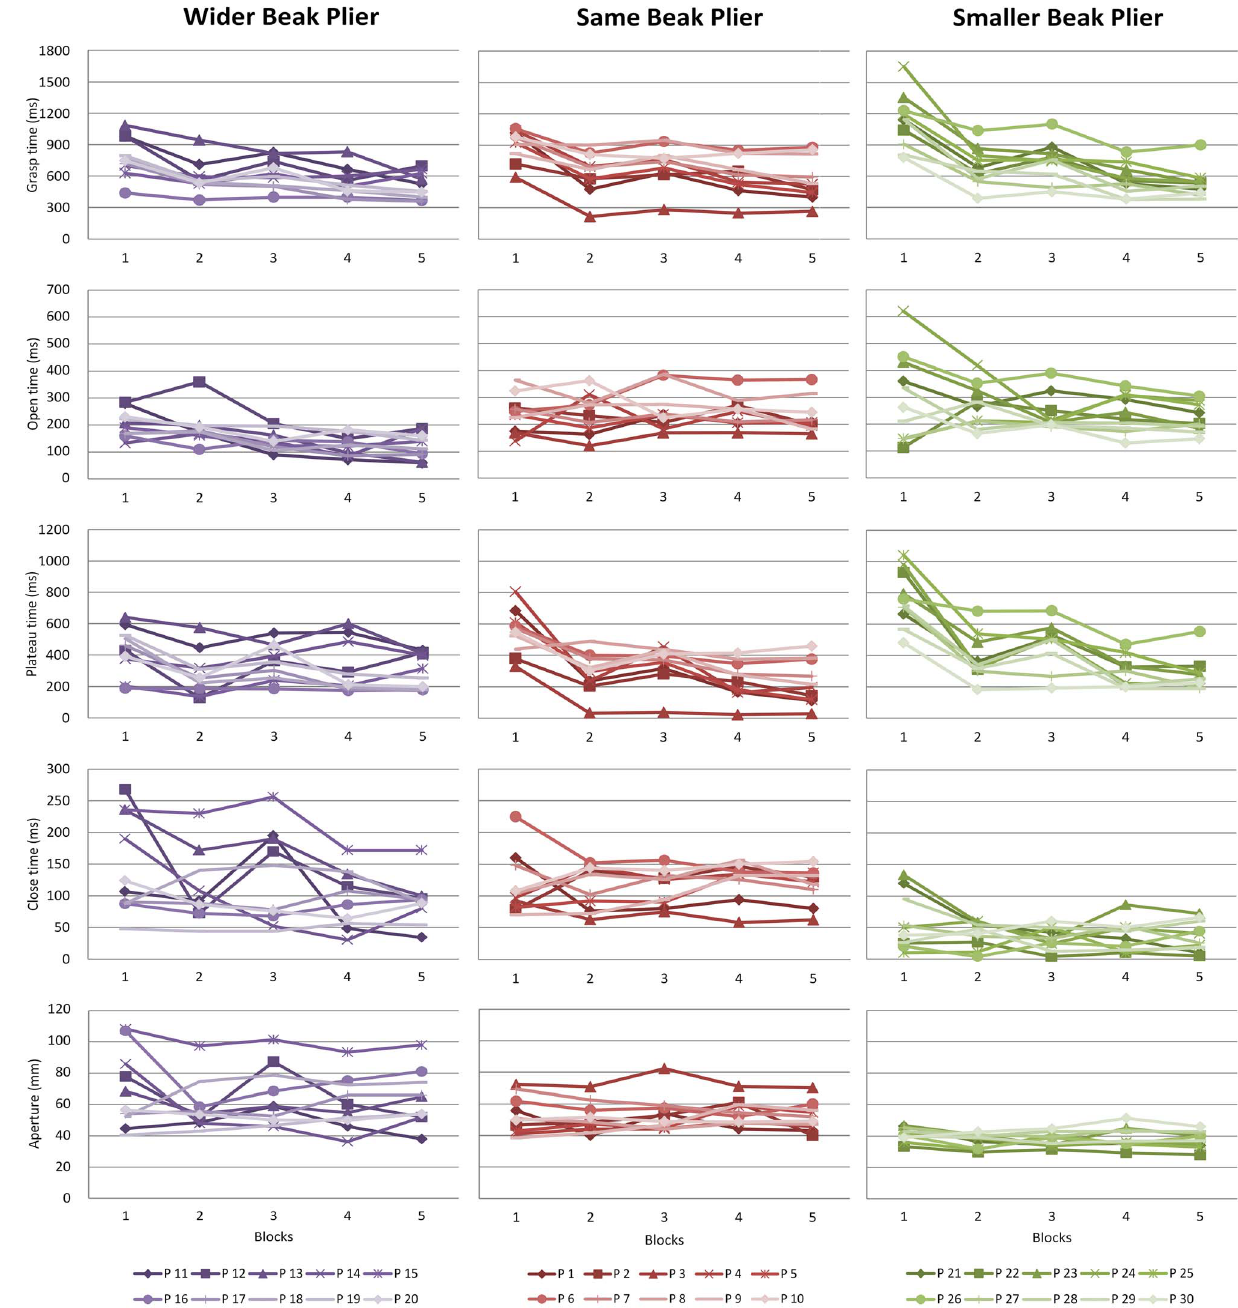
Figure 4. Individual learning paths. Changes over practice trials in hand opening, plateau phase, hand closing, and in aperture for all participants (10 participants in total for each pair of pliers). Blocks of five trials are presented; Block 1: Trial 1–5, Block 2: Trial 51–55, Block 3: Trial 101–105, Block 4: Trial 151–155, Block 5: Trial 195–200. Note that these are not the same blocks of trials that were used in the analyses.